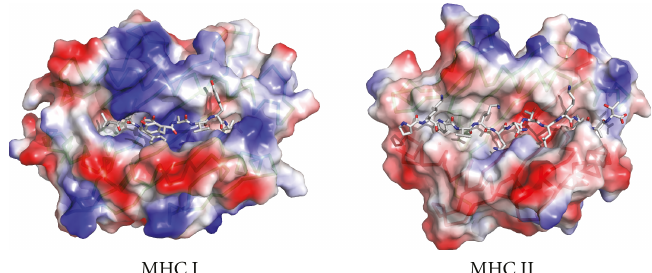
Figure 3: MHC molecule binding groove. The fi gure depicts the molecular surface as seen by the TCR of representative MHC I and II molecules. Note how the binding groove of the MHC I molecule is closed but that of MHC II is open. As a result, MHC I molecules bind short peptides (8 – 11 amino acids), while MHC II molecules bind longer peptides (9 – 22 amino acids). The fi gure was prepared from PDB fi les 1QRN (MHC I) and 1FYT (MHC II) using PyMol. Table 1: Selected T-cell epitope prediction tools available online for free public use.